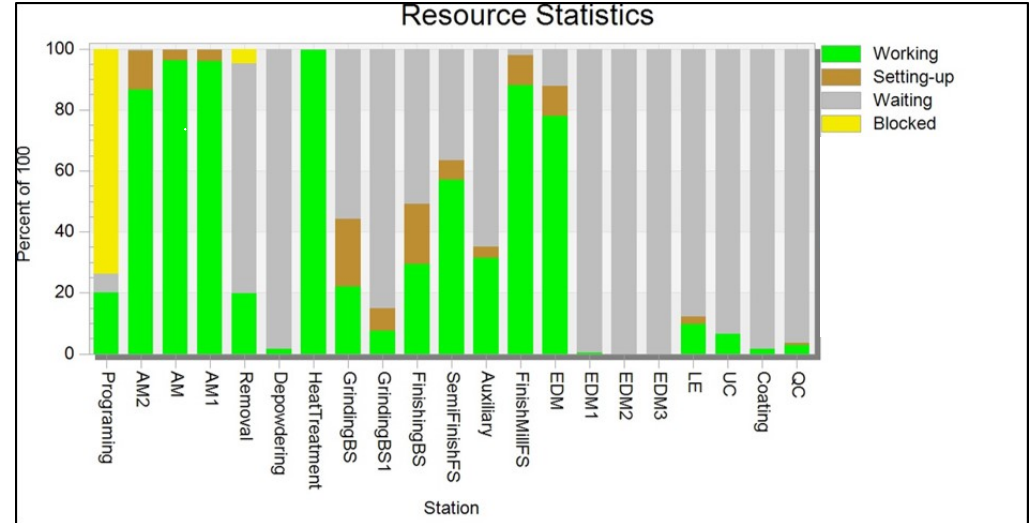
Figure 9. Resource statistics simulation for the AM workflow. The number of inserts produced in one year is 589.